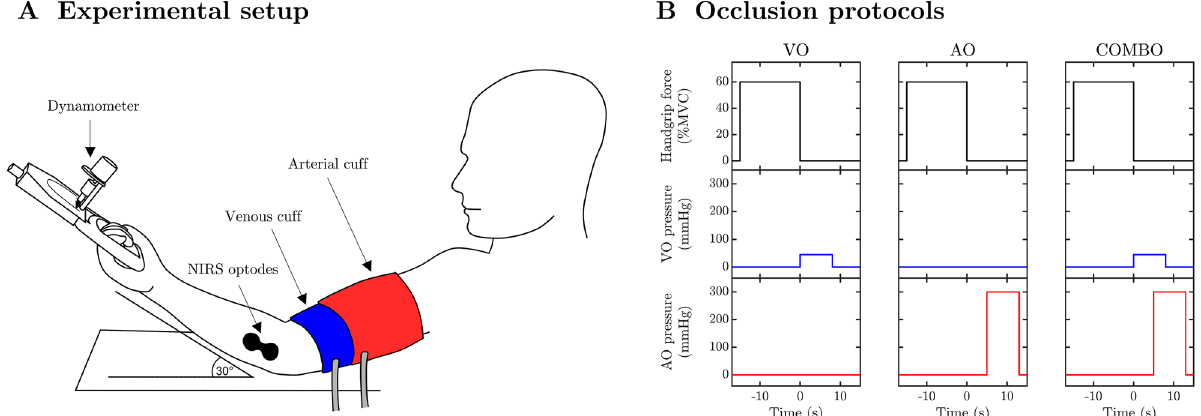
Figure 1. Illustration of the experimental design ( A ) and the venous, arterial and combined occlusion protocols ( B ). NIRS: near-infrared spectroscopy; VO: venous occlusion; AO: arterial occlusion; COMBO: combined venous and arterial occlusion; MVC: maximal voluntary contraction. The illustration in Panel A was created using InkScape (v0.92, Inkscape Project, https ://inksc